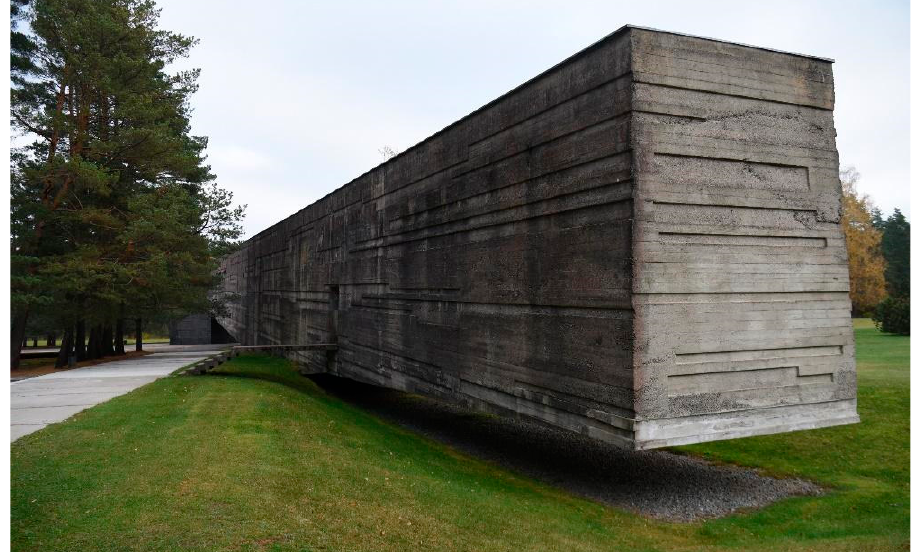
Figure 5. The Salaspils Memorial Ensemble in Latvia, designed in 1967 by sculptors L. Bukovskis, O. Skarainis, J. Zarinš, and architects G. Asaris, O. Ostenbergs, I. Strautmanis, O. Zakamennijs. Photo by V. Petrulis, 2022.